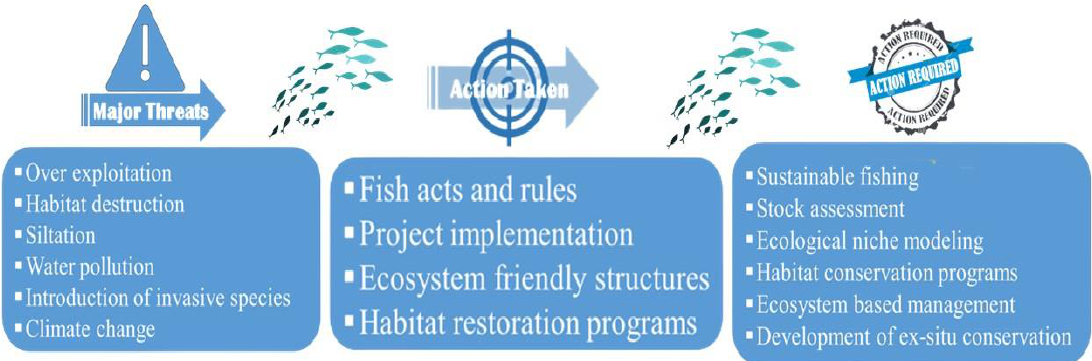
Figure 7. Possible strategies for conservation of N. nandus in the Haor ecosystem